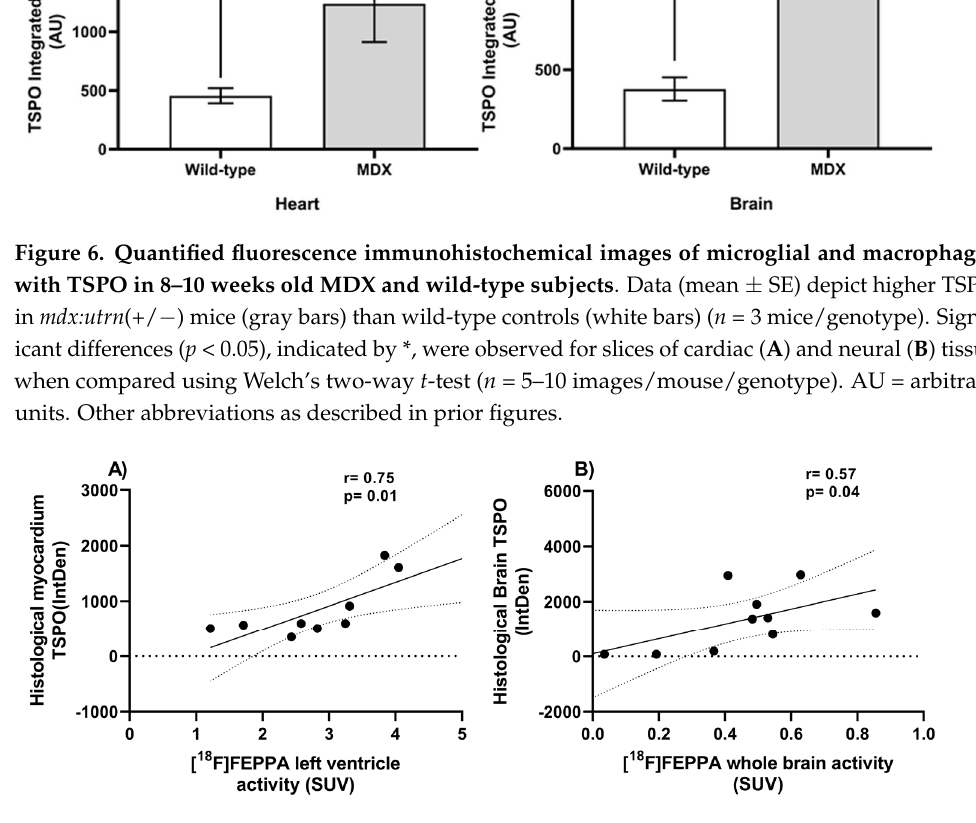
Figure 7. Correlation of [ 18 F]FEPPA activity with histological TSPO fluorescence intensity. Data depict the strong correlation of the left ventricle ( A ) or whole brain ( B ) PET avtivity, with quantified TSPO myocardium or neural tissue fluorescence signal. Pearson product-moment correlation coeffi- cients (r) were calculated on all animals imaged with PET ( n = 9 for heart association with 1 outlier excluded and n = 10 for brain associations, no outlier detected). Significance was considered when p < 0.05. IntDen = Integrated Density, the product of the mean fluorescence intensity and area of selected cell.